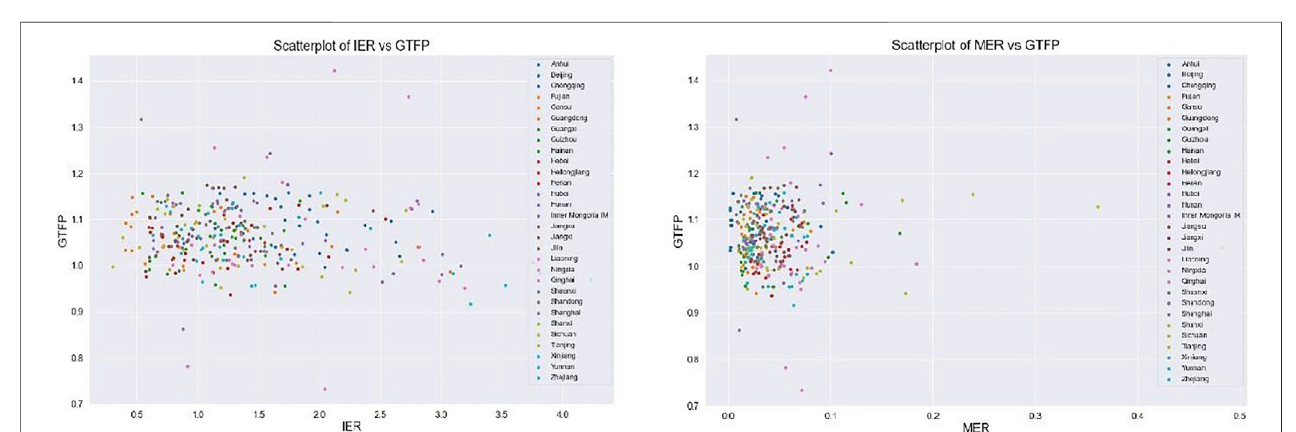
FIGURE 2 | Visualization of the correlation between environmental regulations and